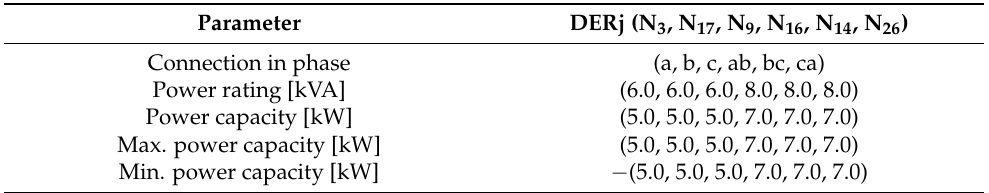
Table 3. Parameters of the